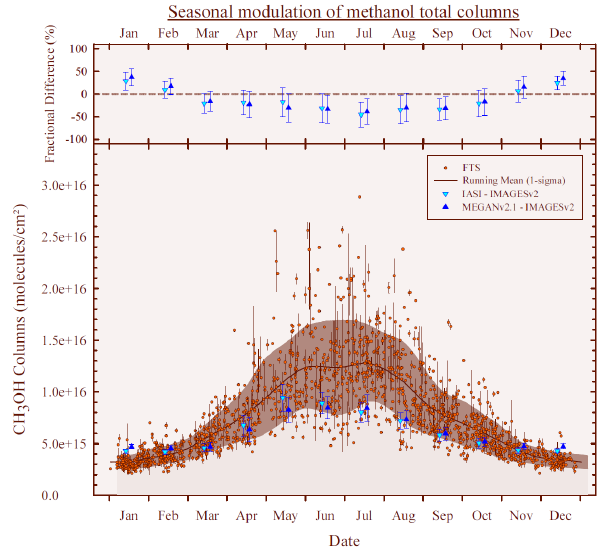
Figure 4. Seasonal modulation of methanol total columns. Dots with vertical lines represent the daily mean total columns over a 1- year time base and their associated standard deviation. The brown curve corresponds to a running mean fit to all data points, with a 15-day step and a 2-month wide integration time. The area corre- sponds to the 1 σ standard deviation associated to the running mean curve. Up and down blue triangles are the monthly means of the model IMAGESv2 simulations for MEGAN and IASI respectively. Upper frame shows monthly fractional difference between FTIR re- sults and IMAGESv2